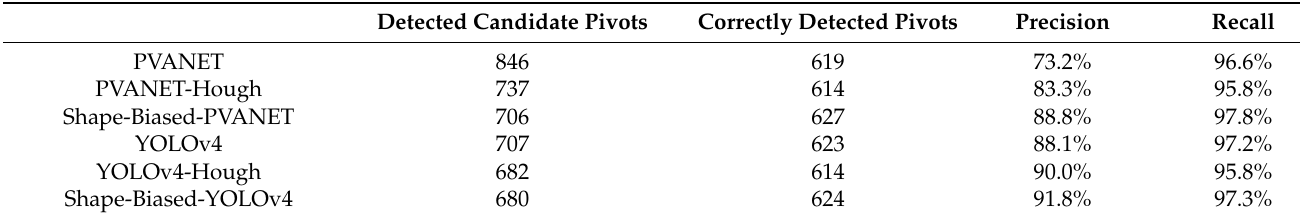
Table 1. The results of PVANET and YOLOv4 with edge image samples extracted using Canny edge detector in the training data. Detected Candidate Pivots Correctly Detected Pivots Precision